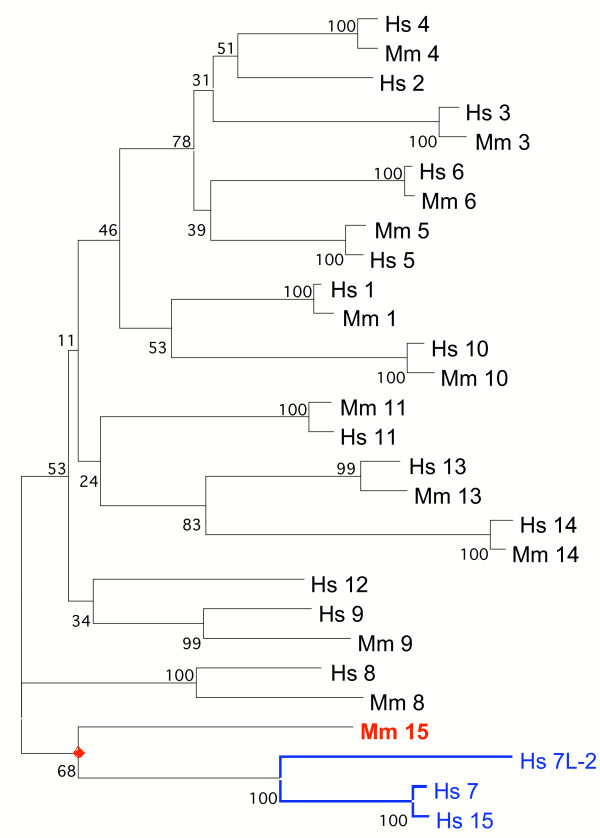
Phylogenetic analysis of human and mouse S100 proteins A neighbour-joining tree of human (Hs) and mouse (Mm) S100 proteins (1 through 15) was constructed using the Poisson correction model and the bootstrap percentage from 1000 replicates is indicated at each node. Results are consistent with the human S100A7 duplications (blue sub-tree) occurring after the divergence of mouse and human in evolution (red node).